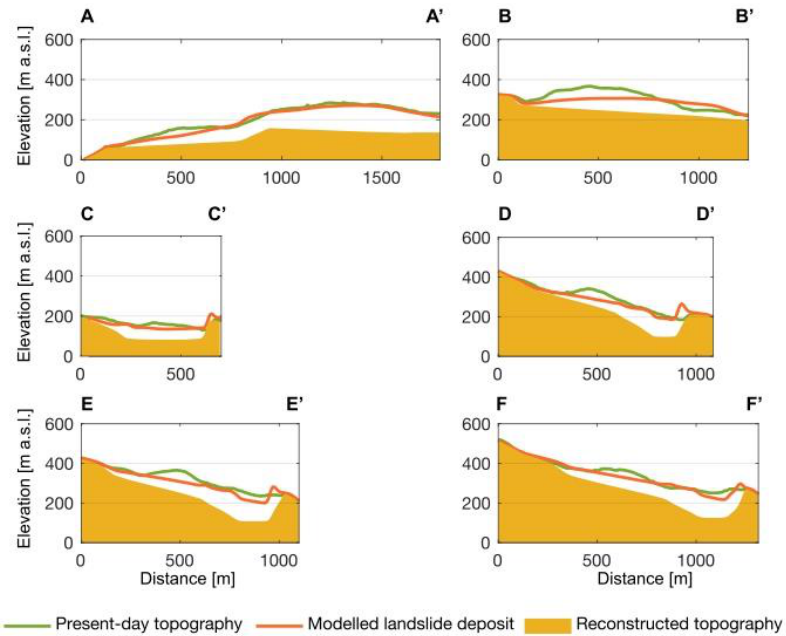
Figure 11. Cross-sections through the landslide deposit with the best-fit parameters of the Voellmy rheology. The topography based on modeling (red line), the present-day topography (green line) and the reconstructed pre-failure topography used for modeling are shown. The scale is the same for every segment. The location of the cross-sections is visible in Figure 10.